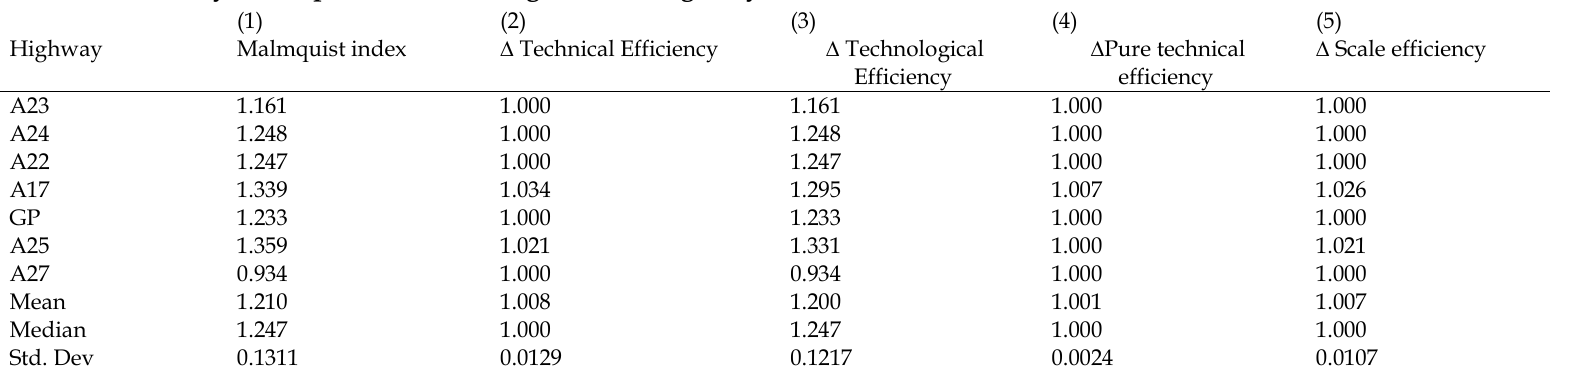
Table 5. Efficiency decomposition for Portuguese PPP